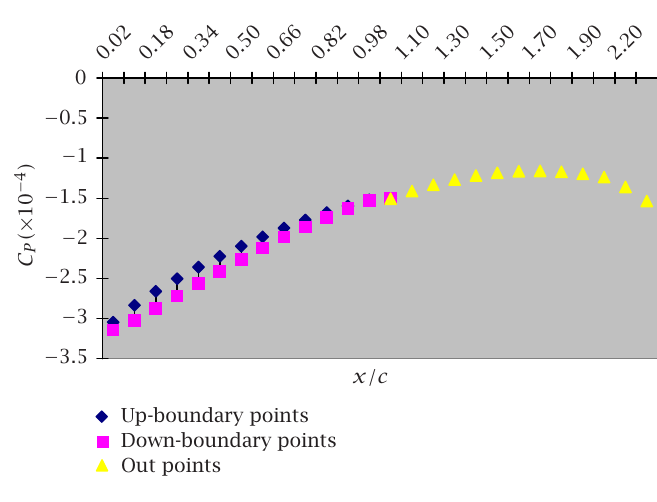
Figure 6.3 . Pressure distribution around the aircraft of Figure 5.1, for linear vortex distribution and speed 2Mach.